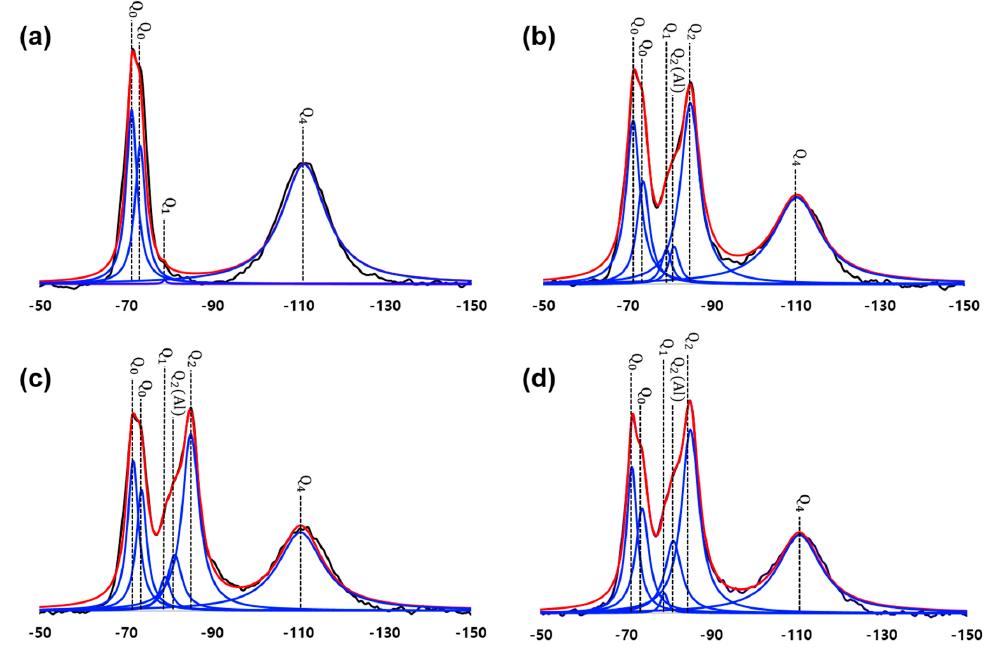
Figure 9. 29 Si magic angle spinning NMR ( 29 Si MAS NMR) spectra and de-convoluted patterns: ( a ) UHPC_1 day, ( b ) UHPC_2 days, ( c ) UHPC_4 days, and ( d ) UHPC_28